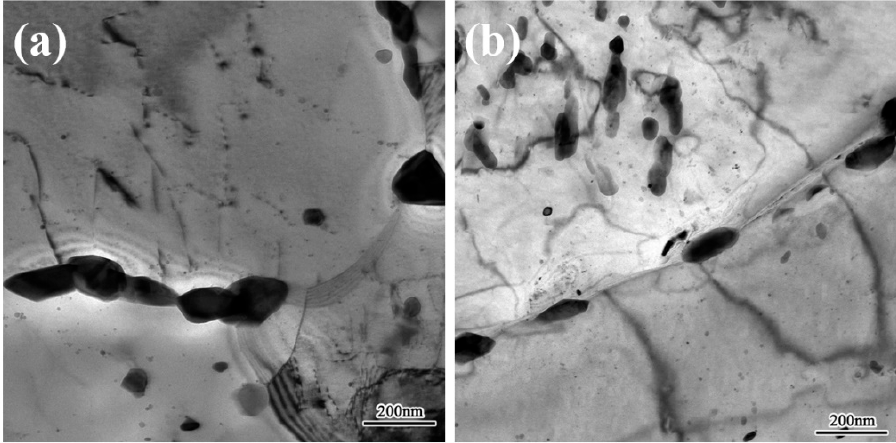
Figure 13. TEM images of carbides microstructure of S1 ( a ) and S2 ( b ) after aging 5000 h at 580 °C.